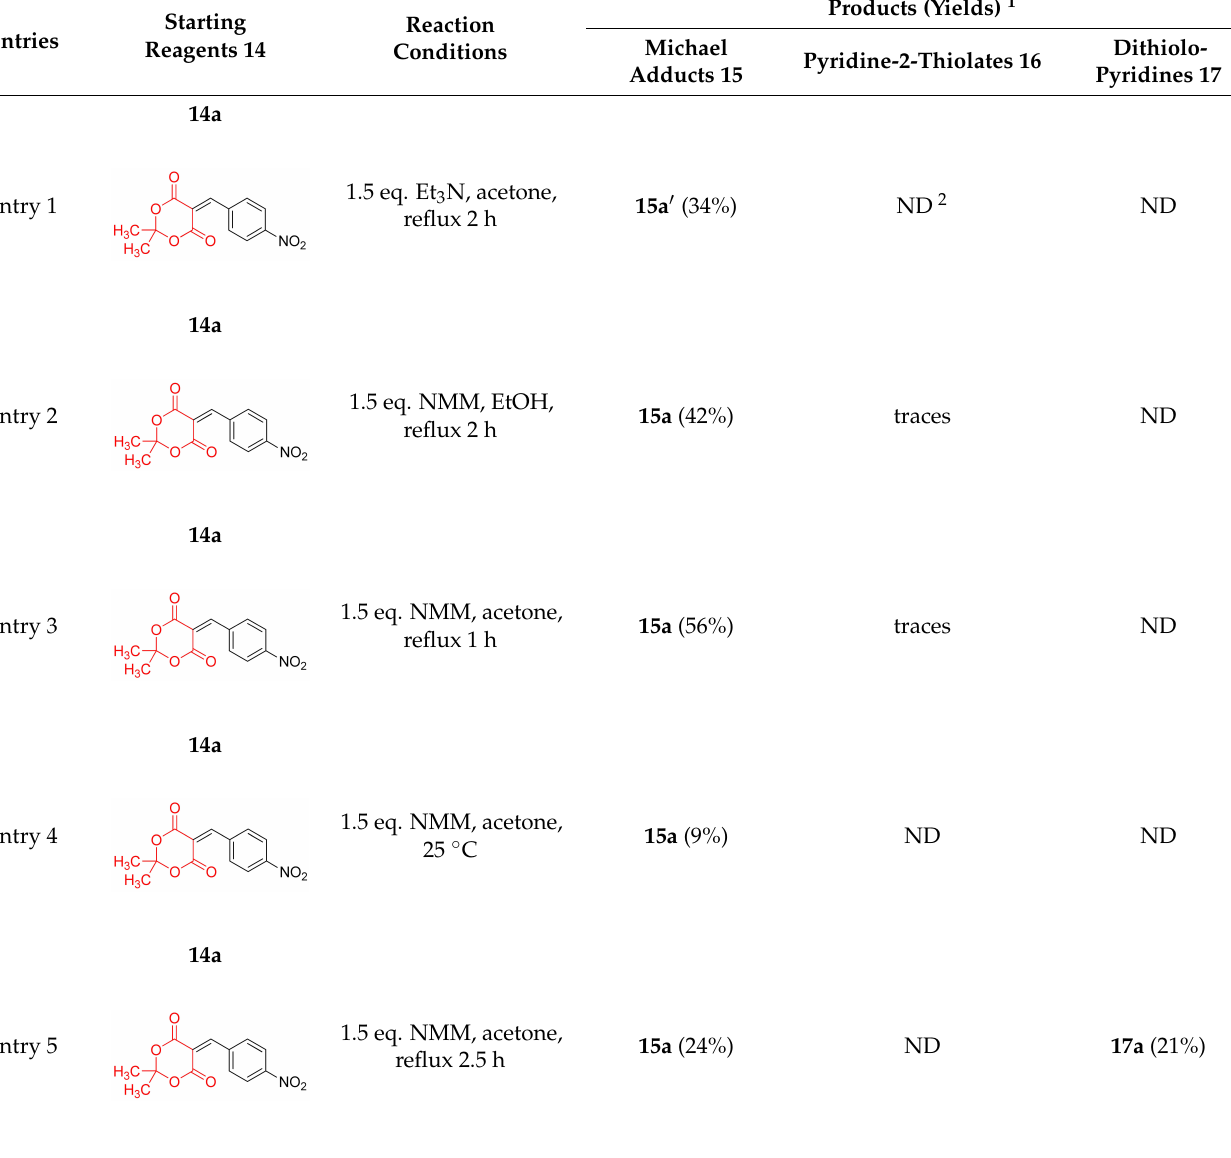
Table 1. The products, conditions and yields in the reactions between 1 and Michael acceptors 14